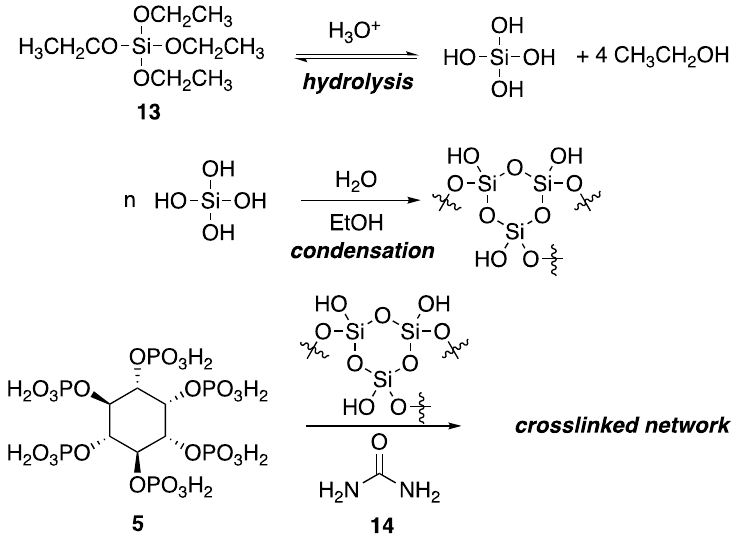
Figure 10. Sol-gel process to prepare 14 – 5 FR coating for polyacrylonitrile (PAN) fabrics.